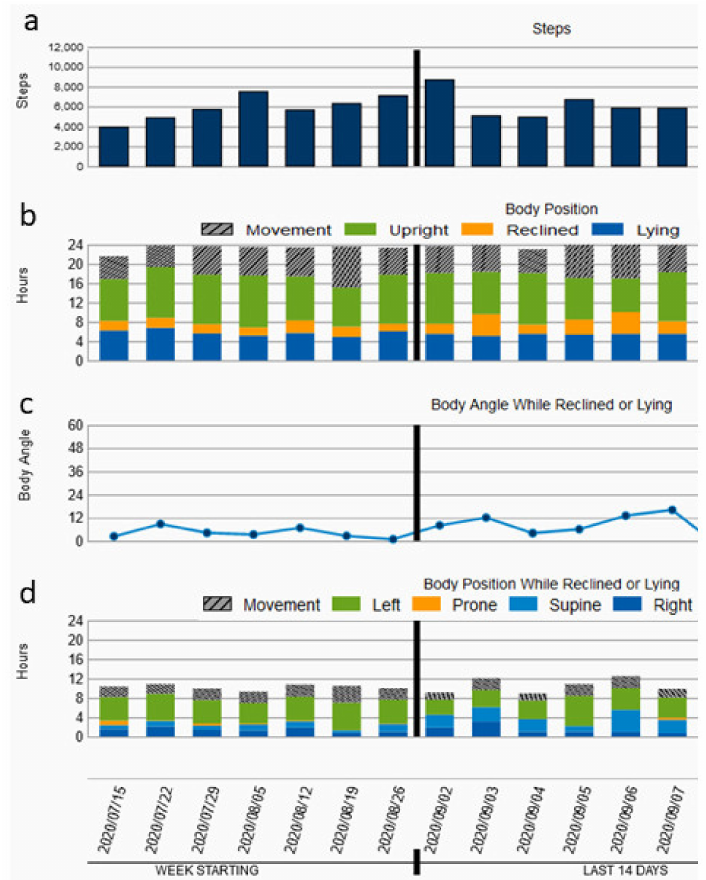
Figure 1. The patient’s ( a ) daily steps, ( b ) body position, ( c ) body angle while reclined or lying and ( d ) body position while reclined or lying over the time of the WCD